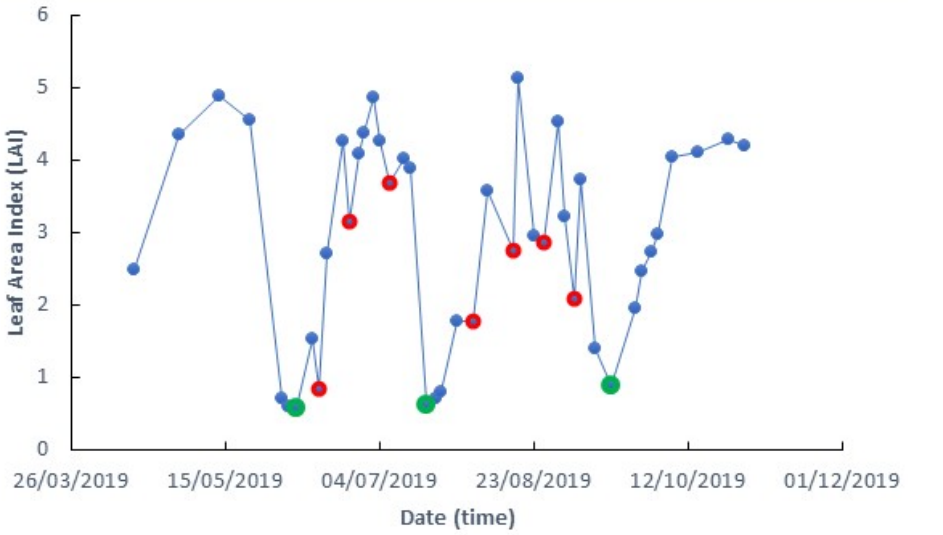
Figure 4. Observed LAI time series of an IPG pixel before smoothing; red dots correspond to LAI minimums that are not linked to mowing events. Green dots are LAI minimum linked to the mowing event.